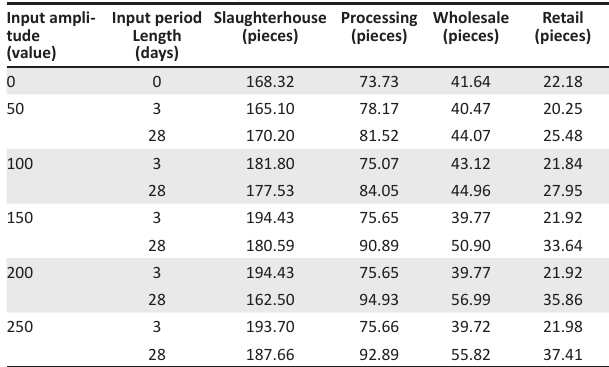
TABLE 4: Stock levels for each amplitude spectrum for a 3- and 28-days long si- nusoidal stimulus (mean